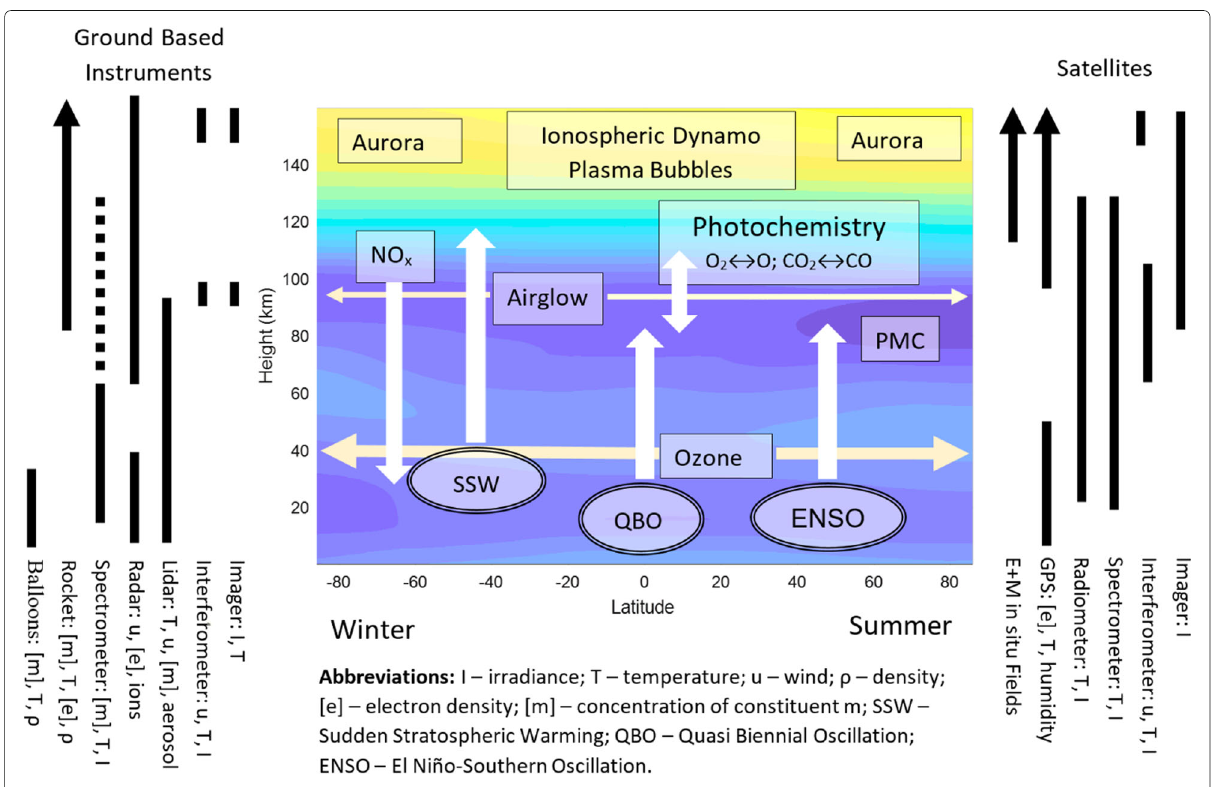
Fig. 3 Overview of the MALTI phenomena. The schematic summarizes the phenomena/processes of importance to the coupling processes in the MALTI as well as ground based (left side of figure) and satellite observation techniques (right side of figure) and their altitude extent. Ovals identify significant sources of internal atmospheric variability, and squares, phenomena of importance. Vertical arrows represent the height range, and horizontal arrows, the latitude range over which the phenomena/processes have influence